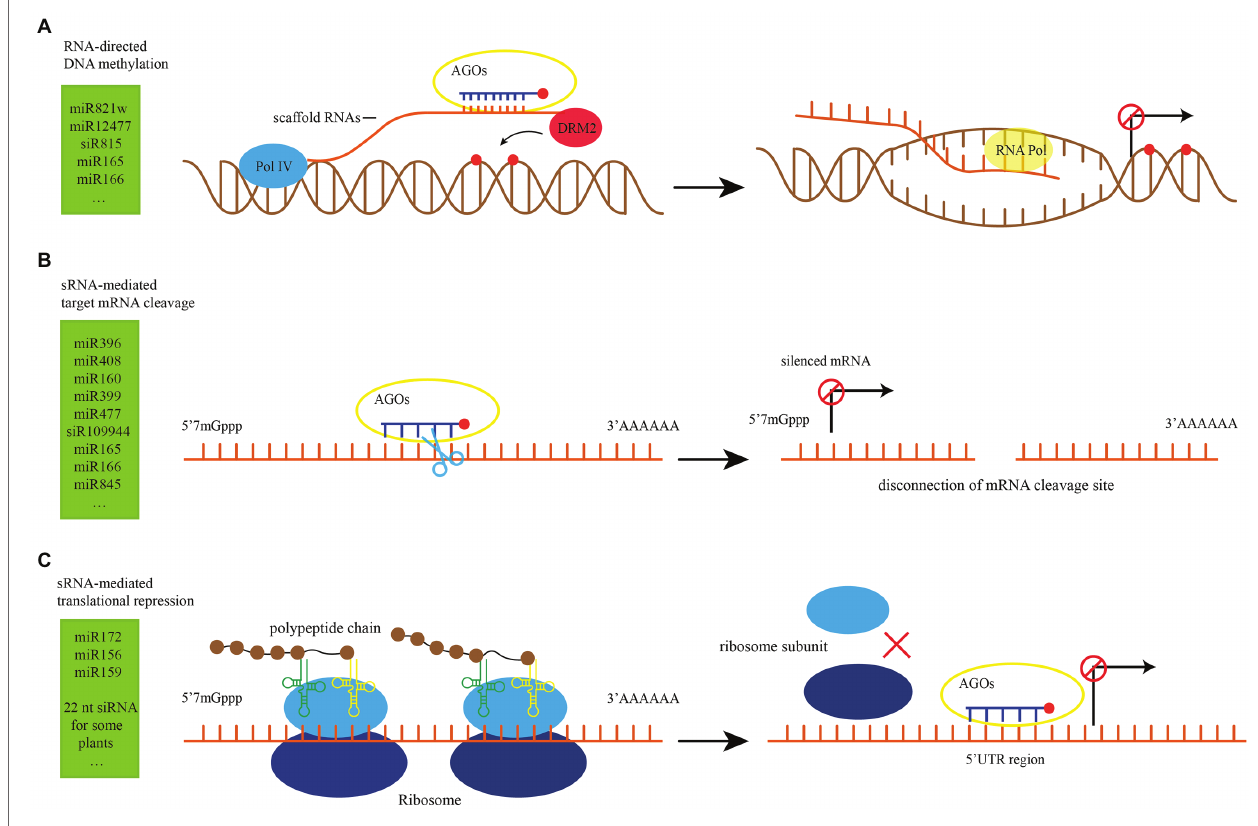
FIGURE 3 | Illustrations of sRNA function. (A) RNA-directed DNA methylation (RdDM) model (Tang, 2020). The scaffold RNAs are produced by Pol V, recruit their complementary sRNA to the RdDM target loci and guides DRM2 to catalyze DNA methylation. (B) sRNA-mediated target mRNA cleavage model. RISC is paired with target mRNAs according to the principle of base complementary pairing. The PIWI domain of AGO proteins has slicer endonuclease activity, and the paired regions are cleaved with the participation of AGO protein. (C) sRNA-mediated translational repression model (Simone et al., 2021): RISC competes with ribosomes for binding to the UTR region of mRNA, which affects the translation process and inhibits the formation of polypeptide chains. RISC: sRNAs carried by RNA-induced silencing complex; UTR: untranslational region; DRM2: DOMAINS REARRANGED METHYLTRANSFERASE